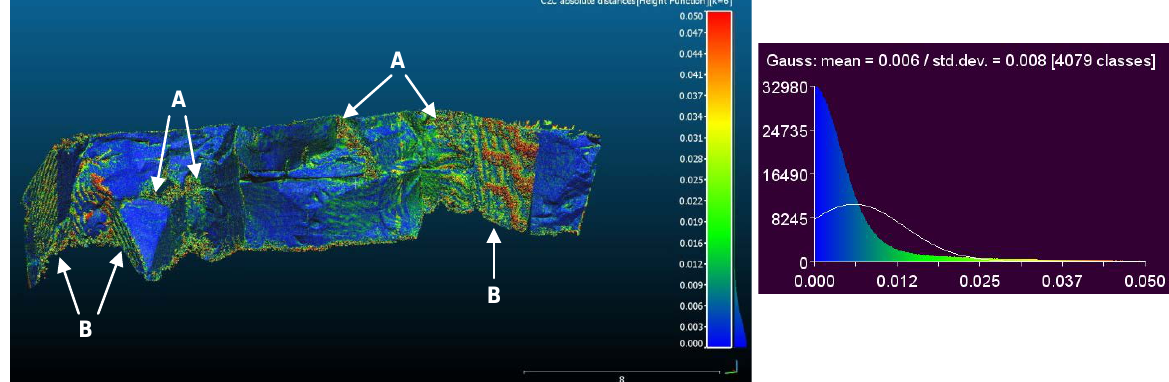
Figure 10. Error mapping of deviation between TLS and Canon EOS